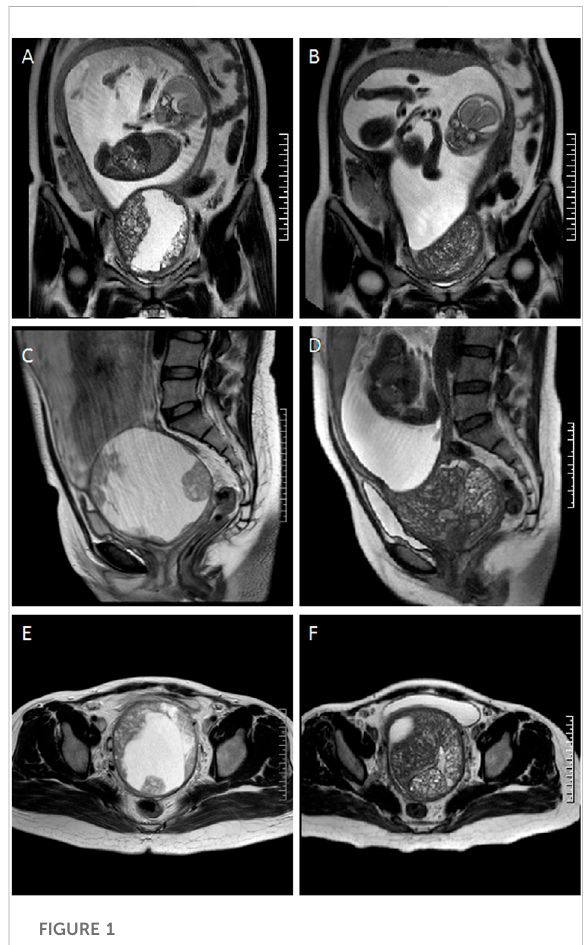
FIGURE 1 Comparison of the magnetic resonance images of the tumor atthecoronal,sagittal,andaxialplanebeforeandafterrupture. (A) , (C) and (E) tumor at 20 weeks (before rupture) was shown. (B) , (D) and (F) tumor at 22 weeks (after rupture) was